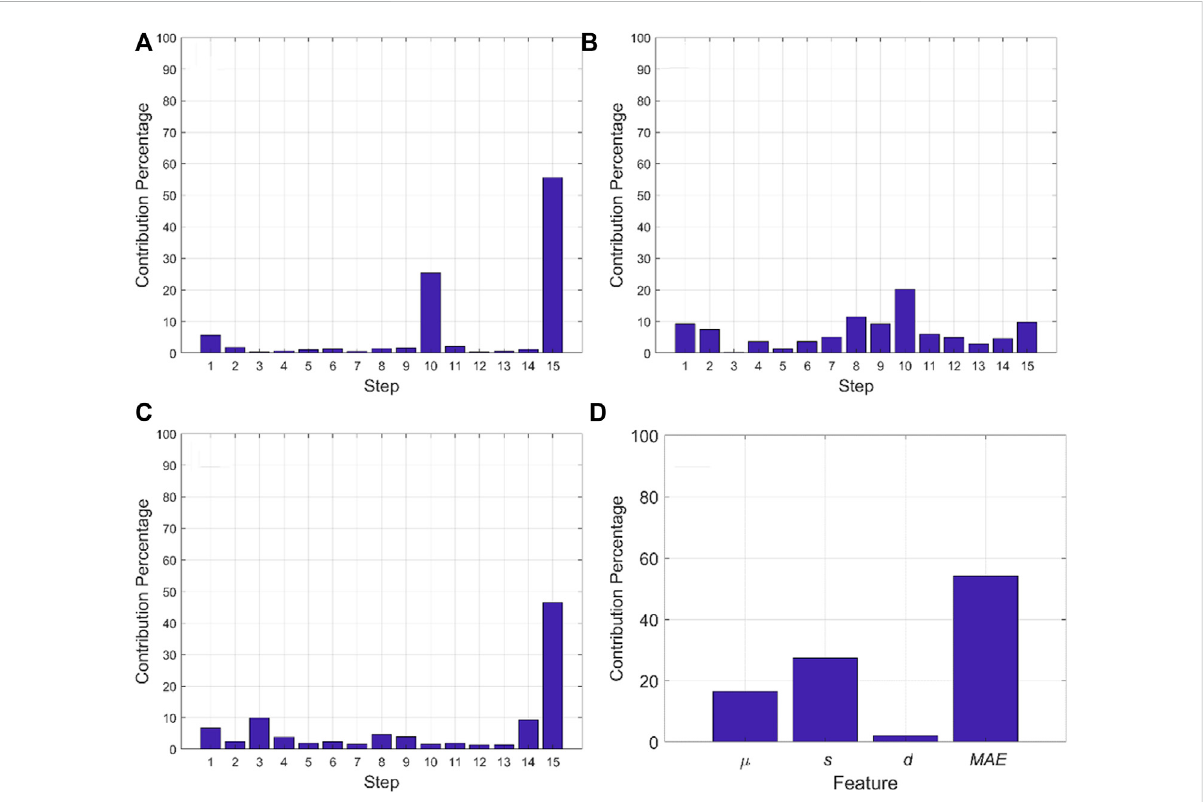
FIGURE 10 Step-wisefaultdiagnosisforcyclenineoffaultscenario5 (A) MPCA SC (B) MPCA DTW ,and (C) FSM,and (D) feature-wisefaultdiagnosisfromFSM. BothMPCA SC andFSMcorrectlyattributethefaulttothelaststepofthecycle,whileMPCA DTW wronglyattributesthefaulttostep10.FSMalsoshows the clearest diagnosis among all methods. FSM can also further drill down the fault to the feature level where the standard deviation and MAE are